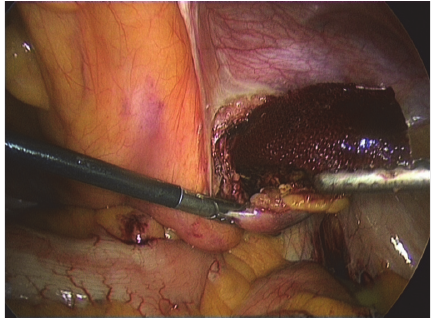
Figure 3: Polypropylene mesh is easily removed by simply pulling it out of the cystic cavity.